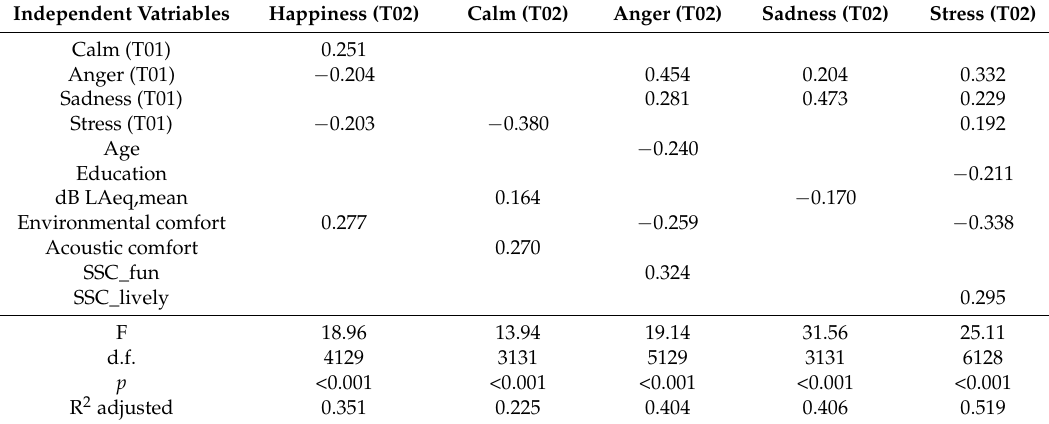
Table 6. Effect (standardised Beta) of the urban environmental experience (UEE) on the four basic emotions and perceived